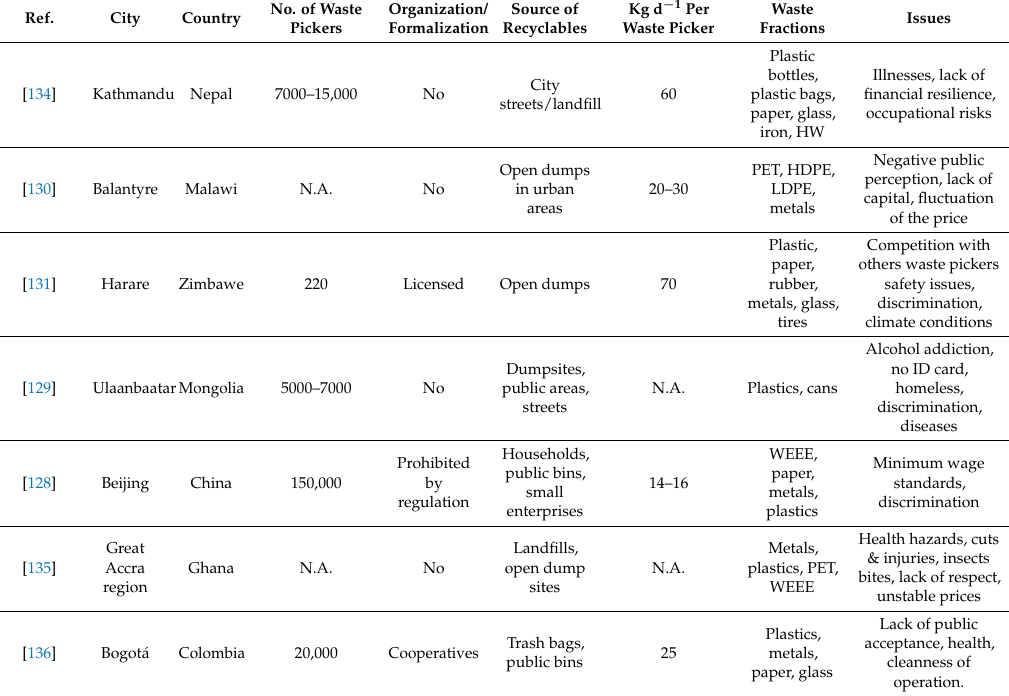
Table 3. Comparison of the waste pickers’ activity among seven different countries worldwide.